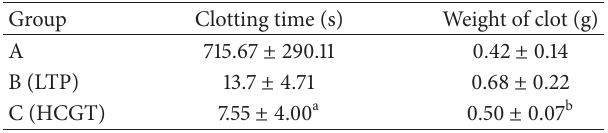
Table 1: Comparison of clotting time and weight of the clots between groups A, B, and